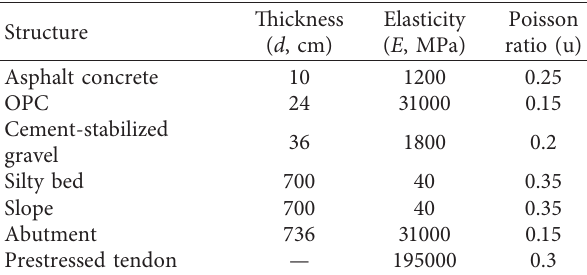
Table 3: Material parameters.